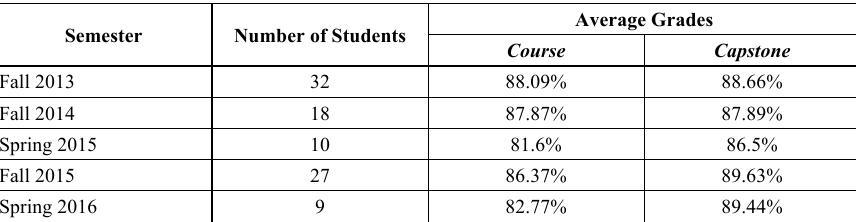
Table 3. Average grades for the course and capstone